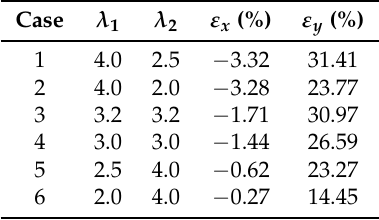
Table 4. The actuation strains with different prestretches for θ = 150 ◦ , Φ = 7.5 kV.